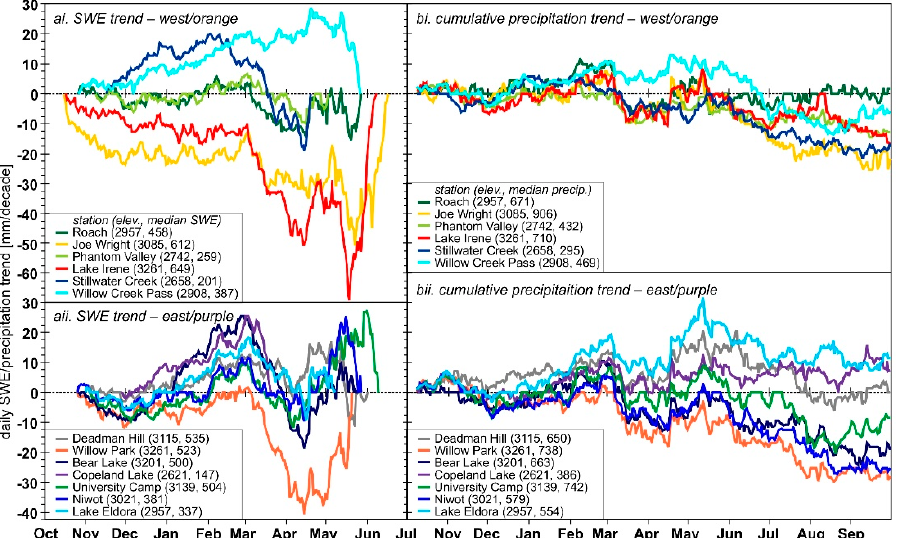
Figure 7. ( a ) SWE and ( b ) cumulative precipitation daily trends for i. orange and ii. purple stations, as per Clow (2010) shown in Figure 1. For each station, the median peak SWE and median cumulative precipitation from October 1st through the complete disappearance of the snowpack are summarized in the legends.